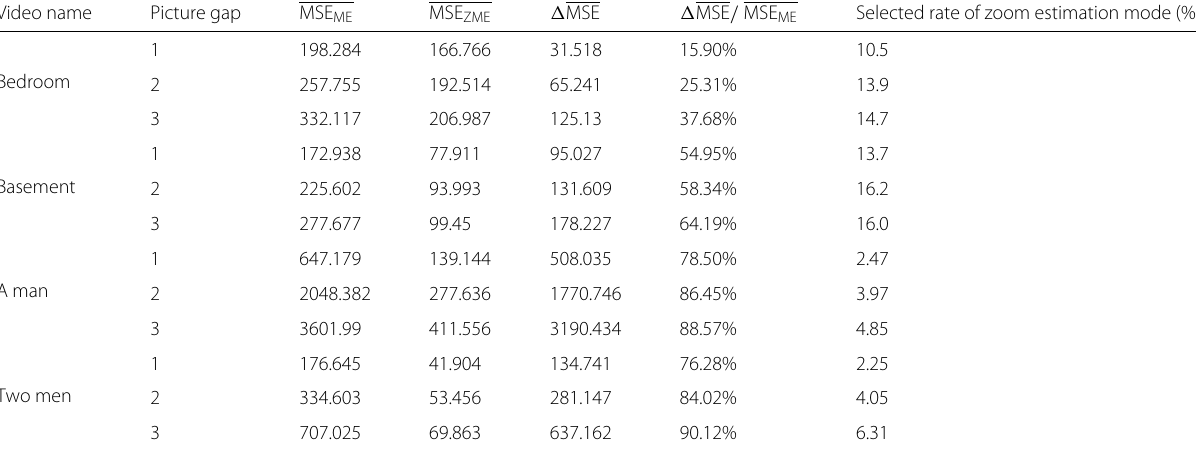
Table 4 Averages of MSEs in depth video according to frame gap in 16 × 16 block